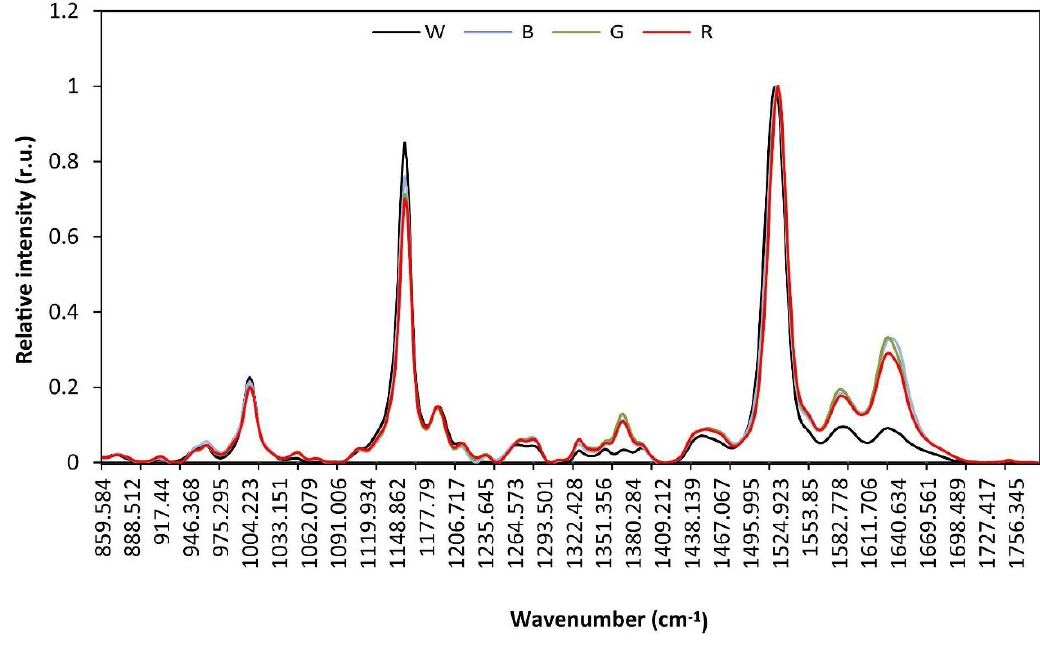
Figure 4. Raman spectra of intact Synechococcus sp. cells exposed to blue (B), green (G), red (R) and white (W) light.